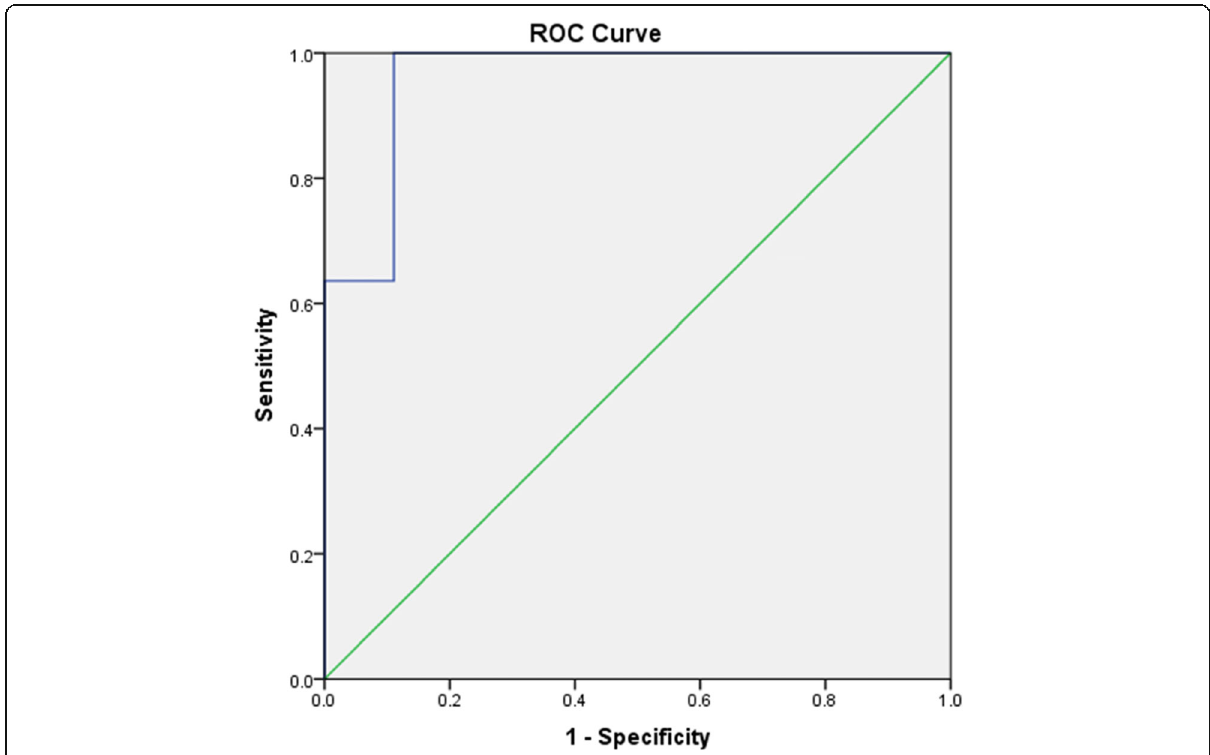
Fig. 5 ROC curve for FASTT as a predictor of birth weight > 4000 g